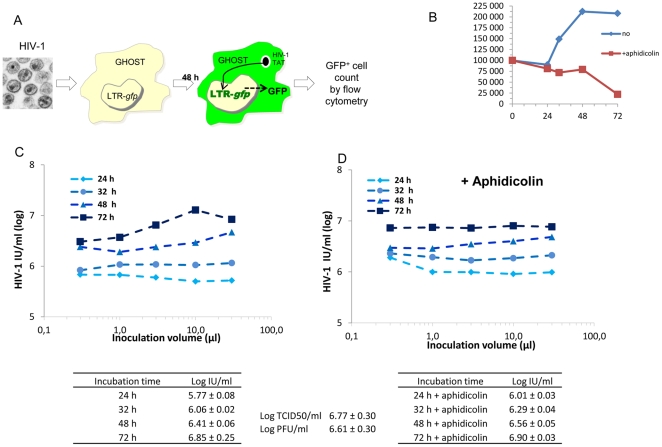
Calculation of HIV-1 NL4-3 titer using GFP expressing indicator cells.HIV-1 (NL4-3 strain) stock was titrated both by serial dilutions in SupT1 cells and GHOST cells. End-point titration using the lymphocytic cell line SupT1 (data not shown) was based on the appearance of syncytia and took up to 2 weeks. The GHOST indicator cells were used for HIV-1 titration by flow cytometry. These cells express the GFP protein under the control of the HIV-1 LTR that can be activated by Tat from the incoming HIV-1 (A). GHOST cells seeded one hour before were infected with serial 3-fold dilutions of HIV-1 stock in the absence (C) or presence (D) of 1 µg/ml aphidicolin. At various times post-infection, cells were collected, fixed and GFP expression analyzed by flow cytometry. In parallel, at every time point, the cells were collected from non-infected wells to count the cell number for cell growth determination (B).